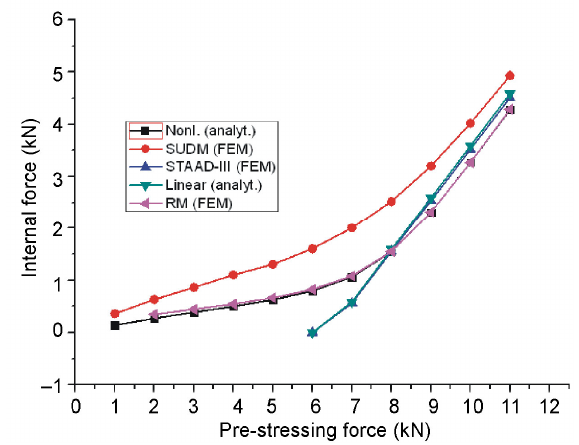
Fig. 5. Graph of general internal force